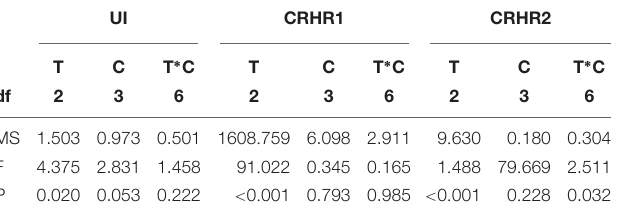
TABLE 2 | Two-way ANOVA summary on effects of Time (T) and Concentration (C) on the expression of UI mRNA, CRHR1 mRNA, and CRHR2 mRNA. UI CRHR1